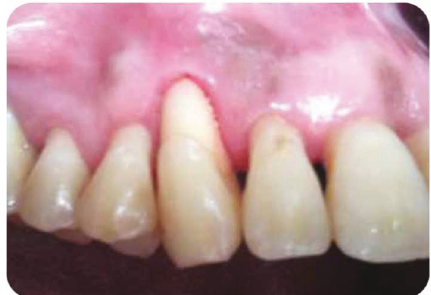
Figure 7: Beginning of soft tissue healing.